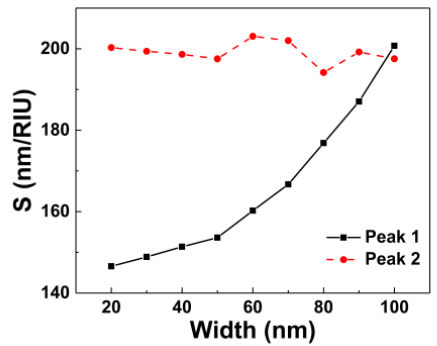
Figure 6. The relation between sensitivity and width of ring nanocavity. Absorption peaks with narrow line widths are useful in detection of the resonance wavelength shift by changing the refractive index. Figure of merit (FOM), which is deter- mined by the sensitivity ( S ) and the FWHM as S/FWHM, is a more significant factor when estimating sensor quality and allows a direct comparison of sensing performance among different sensors [25]. The FOMs of each absorption peak, which varied with the width of the ring nanocavity from 20 nm to 100 nm, were calculated and are shown in Figure 7. The FOM parameters of peak 1 and peak 2 show the identical patterns when the width is changed. With a decrease in width, the FOM of peak 1 increases from 8.2 to 23.6, while the FOM of peak 2 can reach a higher value (65.3) due to its narrower band, as shown in Figure